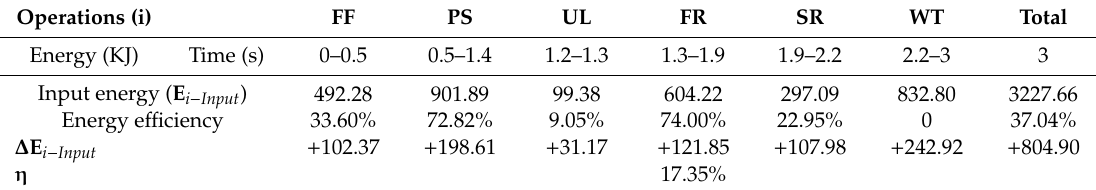
Table 6. Energy consumption of each operation of the traditional hydraulic press (Constant